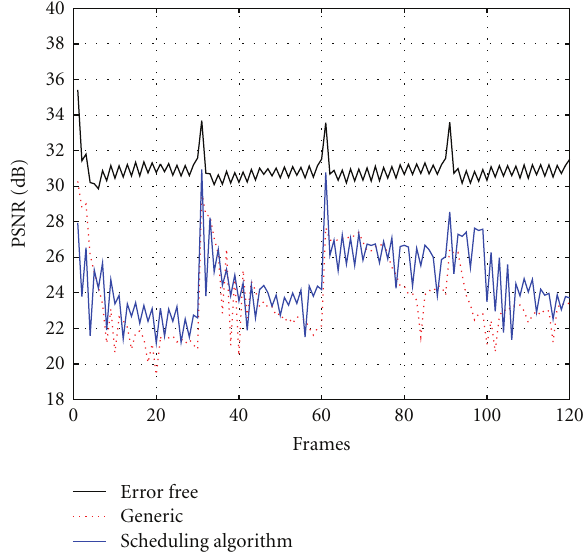
Figure 14: PSNR of crowd sequence for the first 120